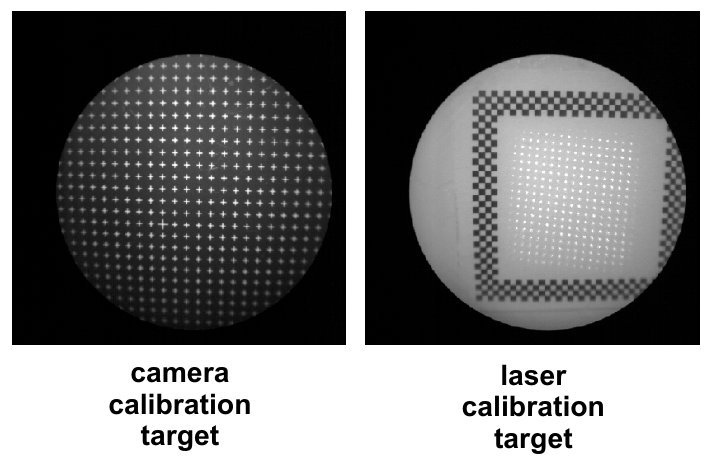
Figure 8. Calibration targets: white crosses on black background for camera calibration and a checkerboard frame for laser calibration.